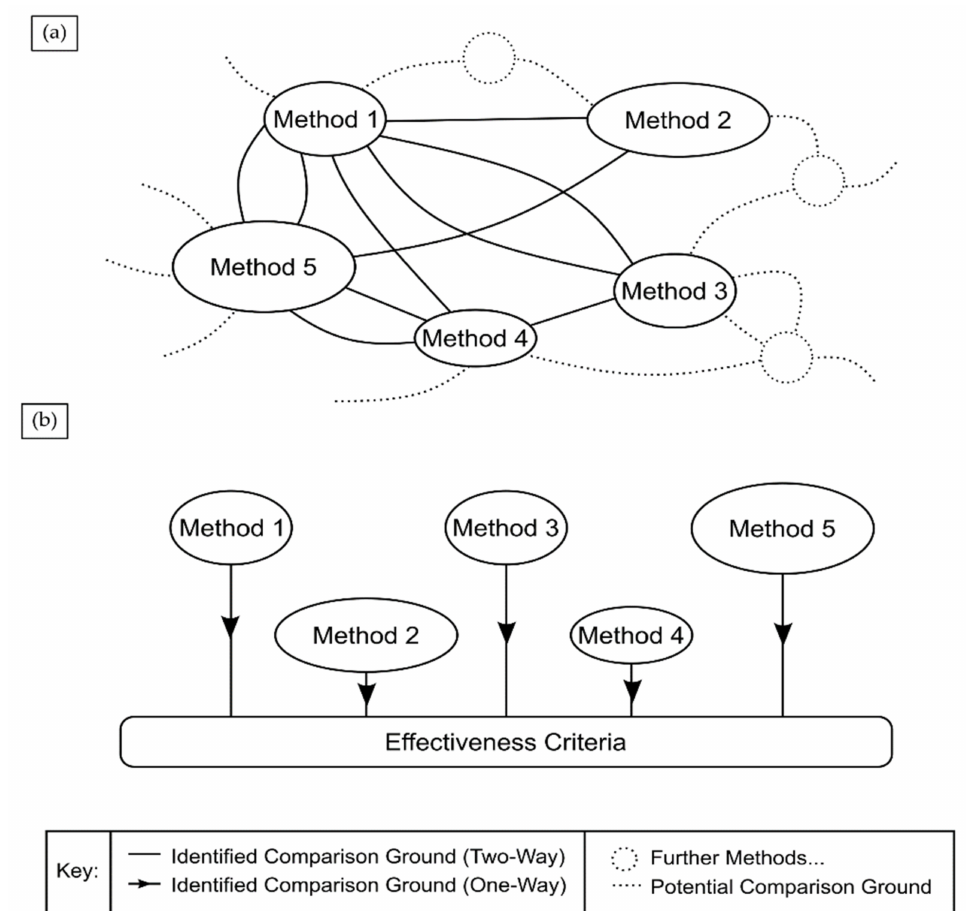
Figure 10. Using criteria greatly simplifies comparison networks. ( a ) Heuristic comparisons are irregular and multi-directional networks. ( b ) Criteria inclusion collapses the network to be regularised and